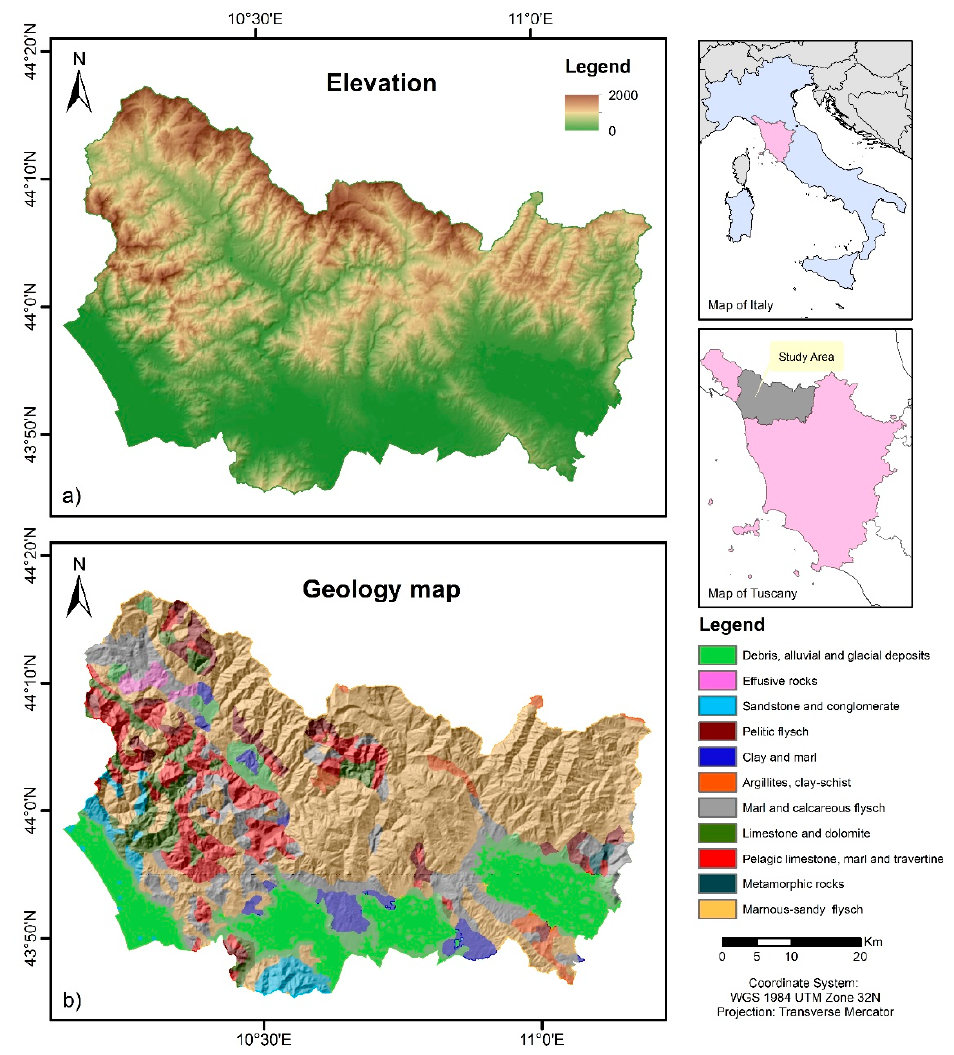
Figure 1. Elevation map generated from a DEM ( a ), and geological map ( b ) showing the geographic location and main lithological units of the study area .